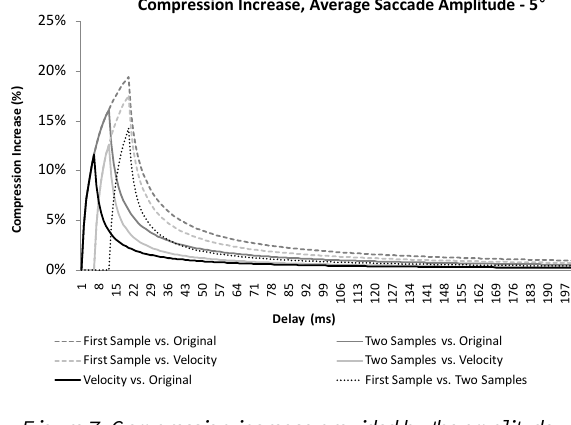
Figure 7. Compression increase provided by the amplitude prediction models. Average Saccade Amplitude is 5°.